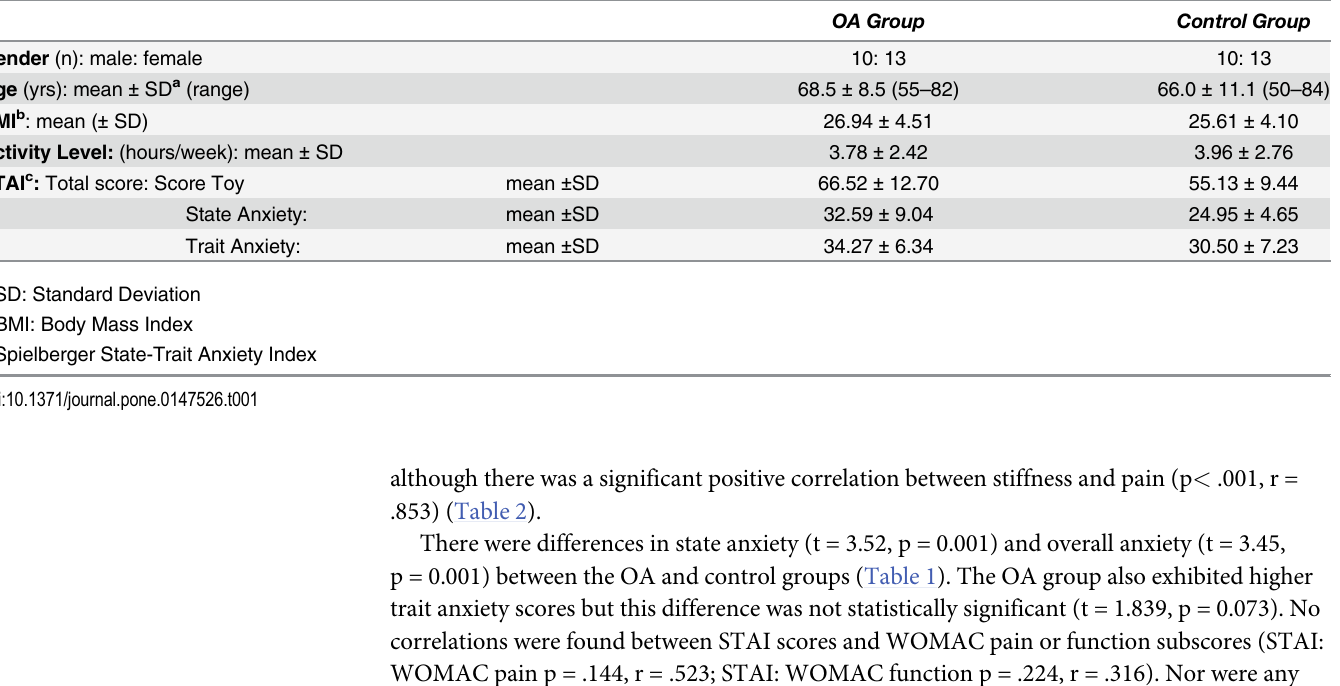
Table 1. OA and Control groups: gender, age, BMI, average activity level and anxiety score comparisons.